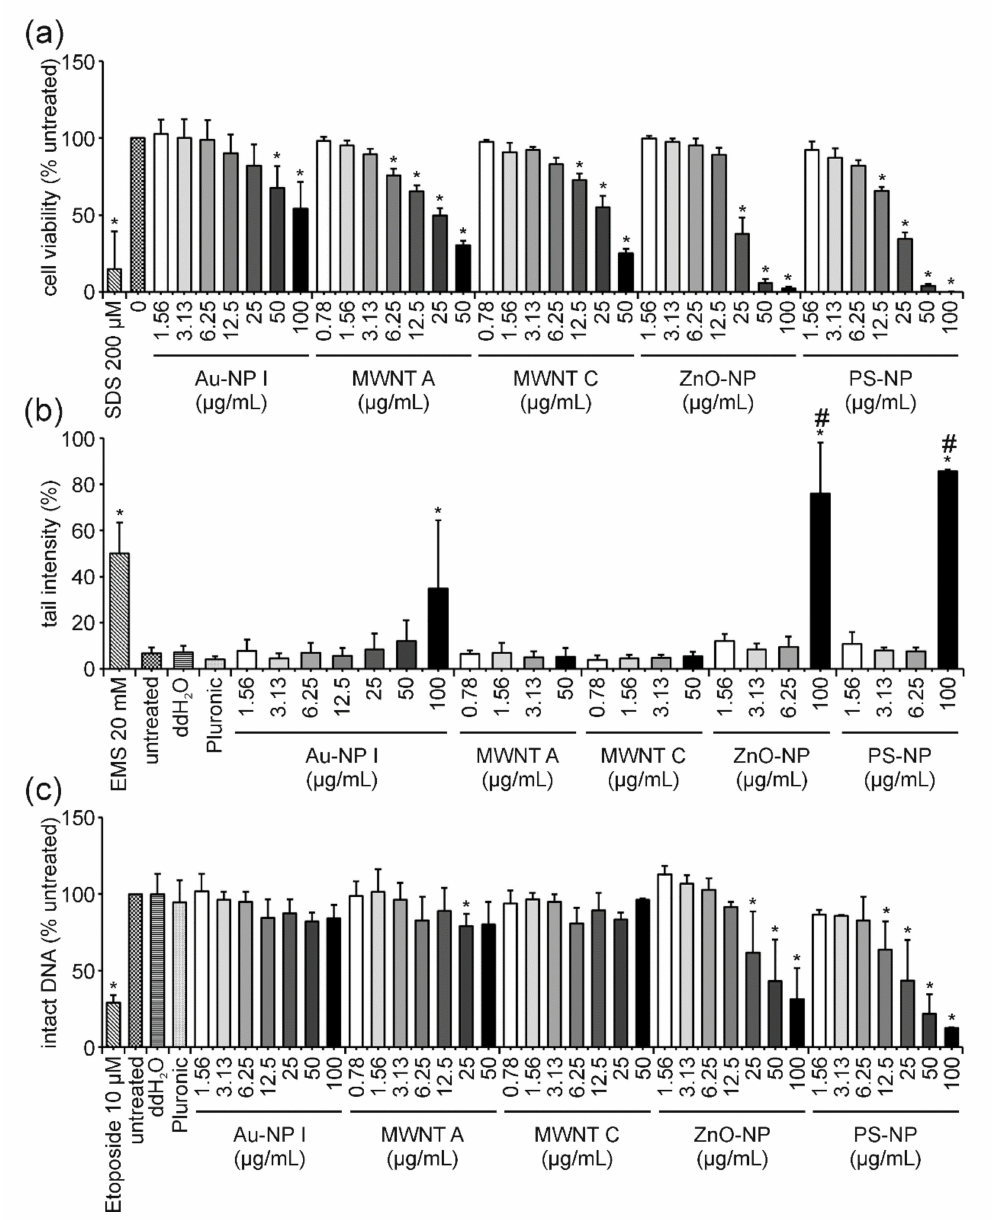
Figure 5. Influence of Au-NP I, MWNT A, MWNT C, ZnO-NP and PS-NP on Jurkat E6-I cell viability and DNA damage induction after 24 h of incubation . Following incubation of Jurkat E6-I cells with different concentrations of Au-NP I, MWNT A, MWNT C, ZnO-NP and PS-NP for 24 h, cell viability was determined by MTT assay ( a ). As a positive control, cells were incubated with 200 µ M SDS (24 h). DNA damage expressed as tail intensity percentage was assessed by alkaline comet assay ( b ). EMS (30 min) served as the positive control. The FADU assay was performed as a second method for genotoxicity assessment ( c ). Treatment with etoposide (30 min) served as the positive control. Results represent the mean and corresponding standard deviations from three independent experiments. # Only a reduced number of comets (i.e., less than 100) could be counted per experiment in these samples. (* p ≤